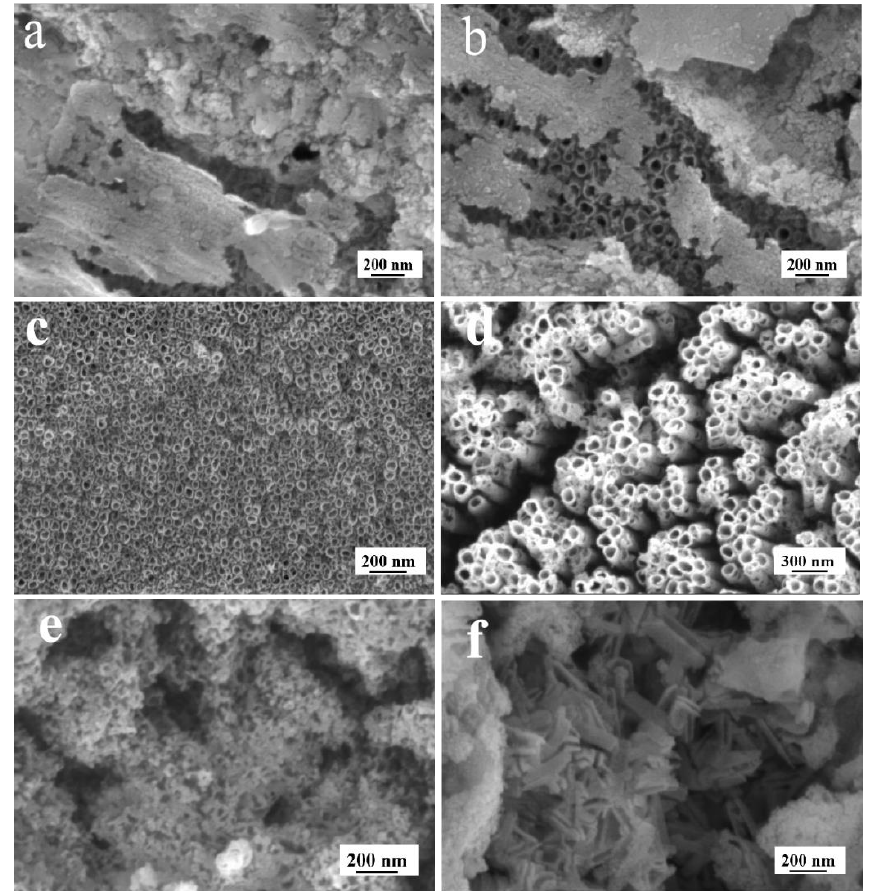
Figure 2. SEM images of Ti wires anodized in ethylene glycol containing NH 4 F. Anodic conditions: time, 30 min; voltage, 20 V; temperature, 25 °C; electrolyte composition, ethylene glycol concentration (50%, v/v ). Concentration of NH 4 F ( ω %): 0.1% ( a ), 0.25% ( b ), 0.5% ( c ), 1.0% ( d ), 2.5% ( e ), 5.0% ( f ).